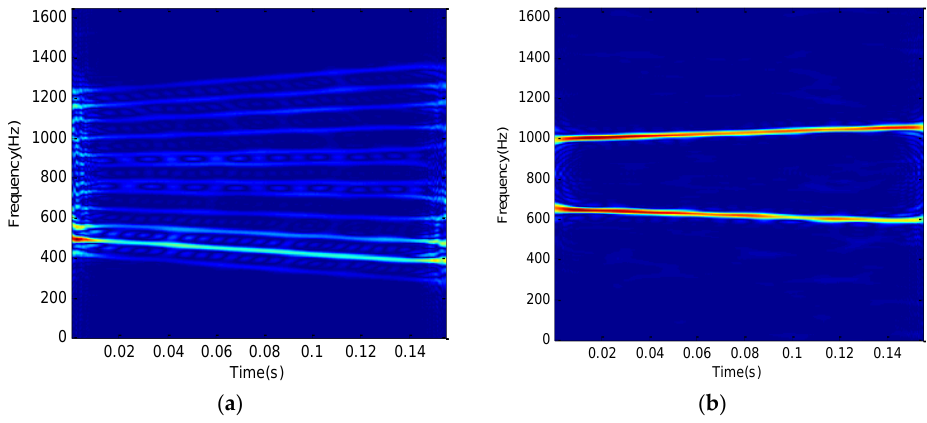
Figure 10. Range cell’s SPWVD: ( a ) the 79th range cell and ( b ) the 128th range cell.